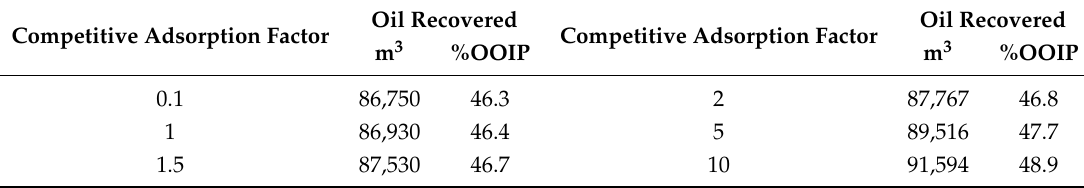
Figure 7. Oil saturation in a P+S overlapped scheme after 500 days for the reference, non-adsorption case ( left ), and considering the adsorption ( right ). Oil recovery efficiency in a random permeability field as a function of the partitioning